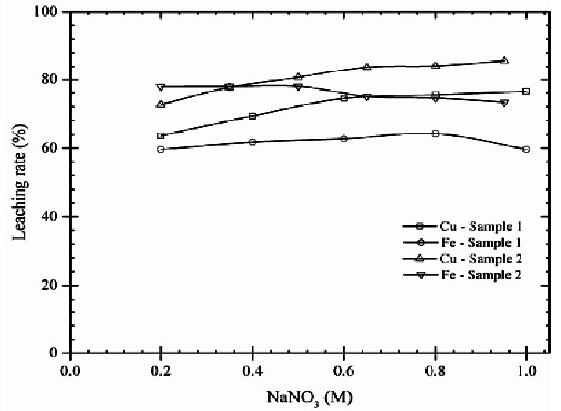
Fig. 3. Effect of NaNO 3 concentration on copper and iron dissolution